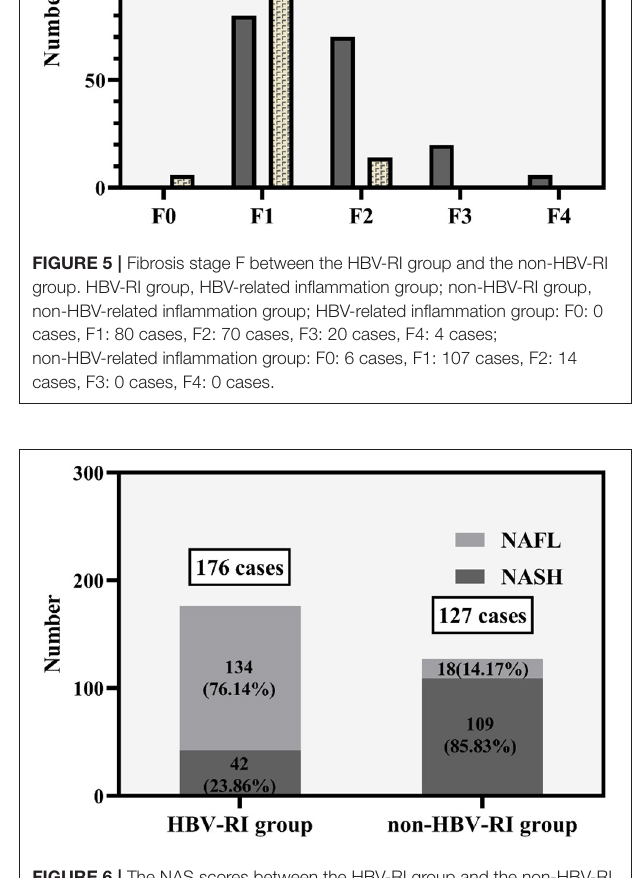
other diseases (5, 21). NASH is progressed from NAFL, which refers to fatty degeneration and inflammation of liver